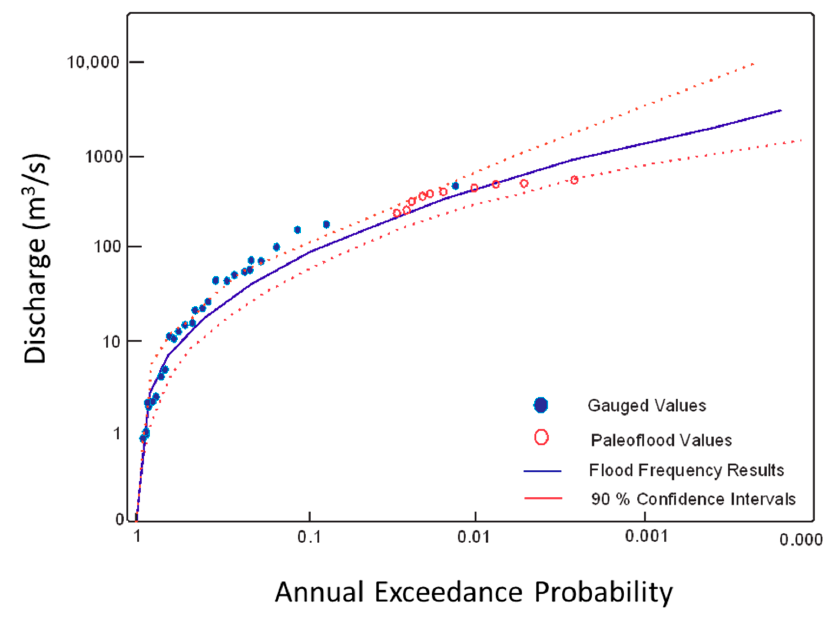
Figure 7. Results from flood frequency analysis using the paleoflood and gauged records. The 2001 flood has a recurrence interval of ~100 years. Discharge values have an uncertainty of ± 25% for the gauged record and an uncertainty of + 50% for the paleoflood record. An annual exceedance probability of 0.01 is equal to a 100-year recurrence interval.